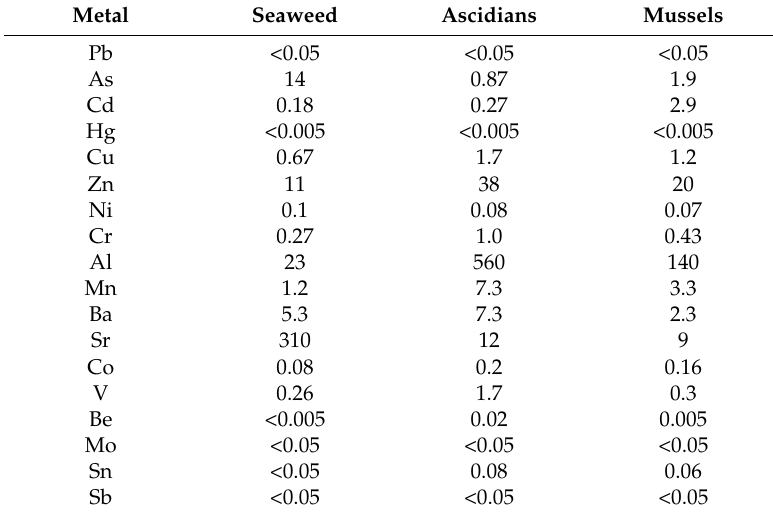
Table 2. The highest concentrations of metals in seafood samples, mg/kg